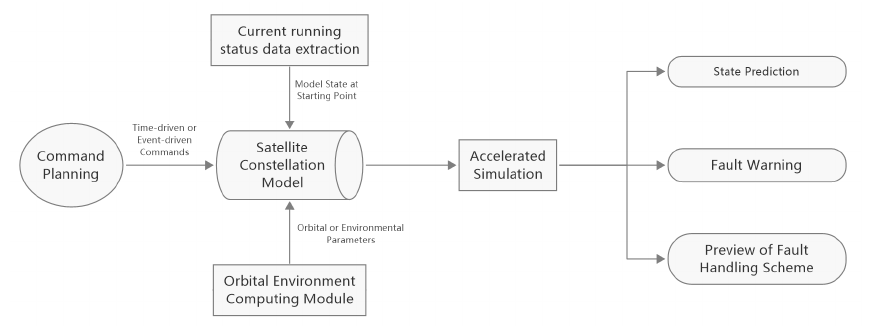
Figure 10. Realization process of state